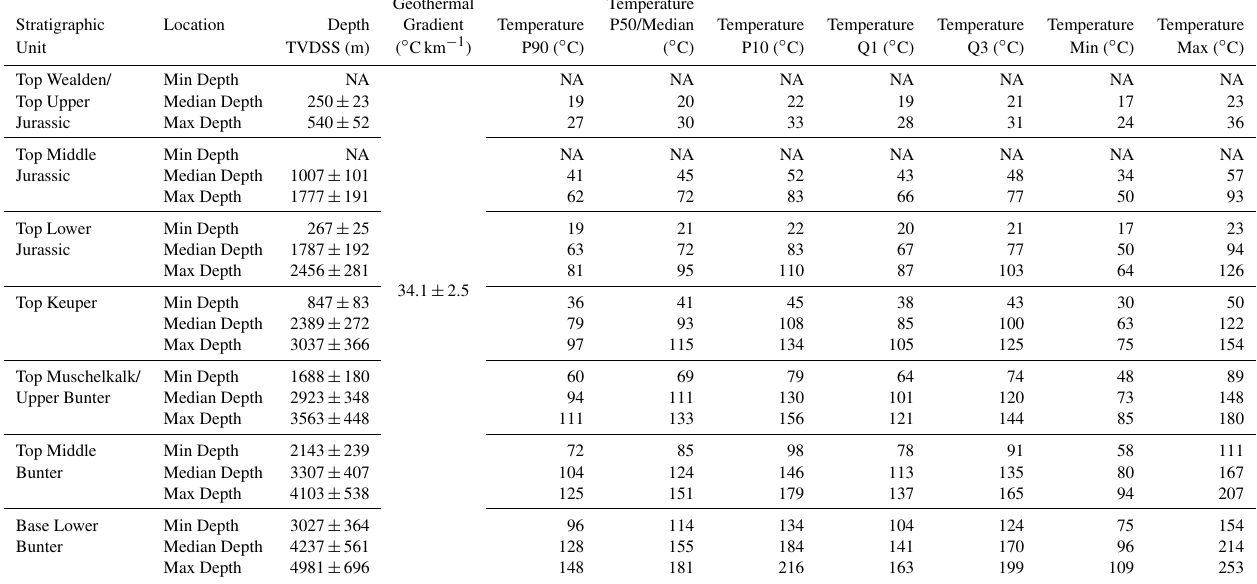
Table 2. Depths and temperature ranges for the tops and the base (Lower Bunter) of the different stratigraphic units of the structural model. P10, P50, and P90 as well as temperatures of Fig. 5 are shown (TVDSS = true vertical depth sub-sea). NA = invalid temperatures below the surface temperature of 10.4 ◦